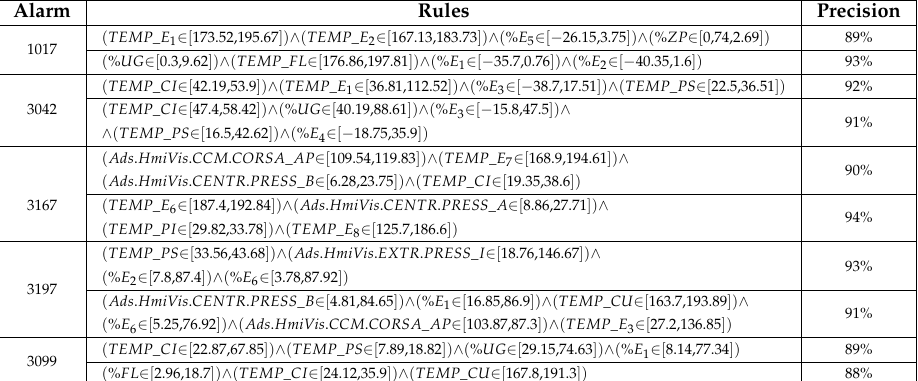
Table 9. Separate-and-Conquer (SeCo) (RUL = 120 s).